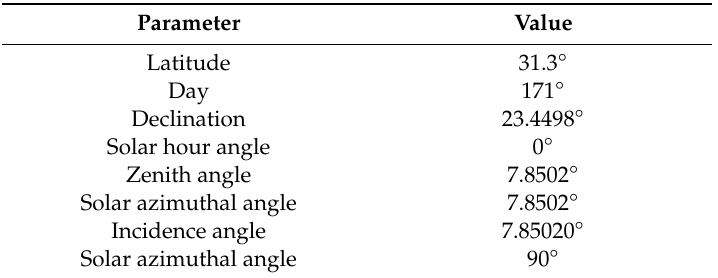
Table 3. Solar angles for solar noon in Agua Prieta, Sonora.